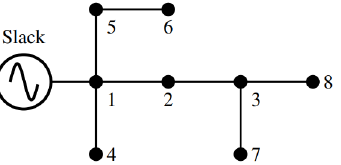
Figure 4. Single-line diagram for the 8-bus test system.